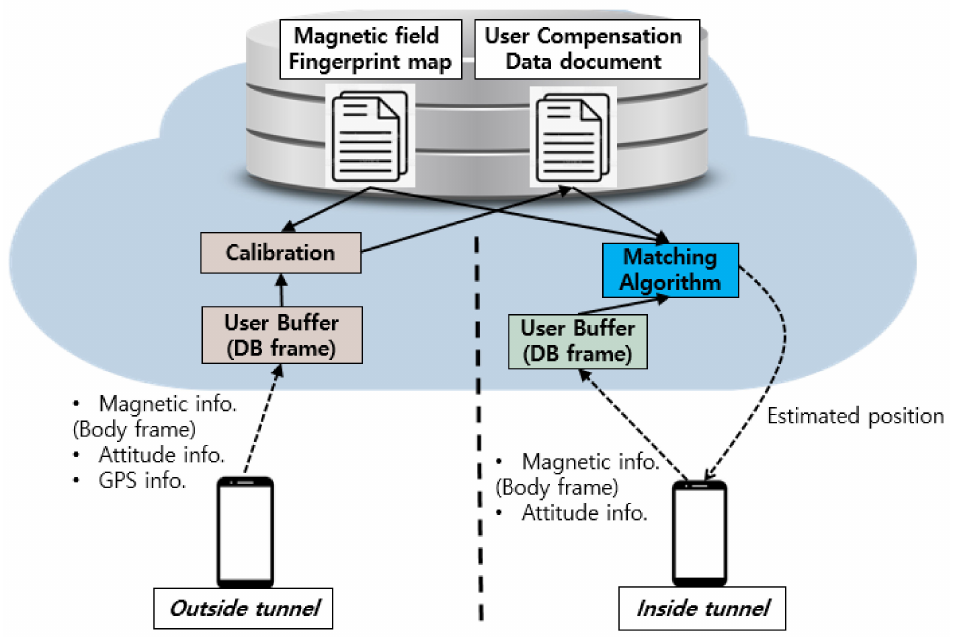
Figure 2. Block diagram of the proposed system.